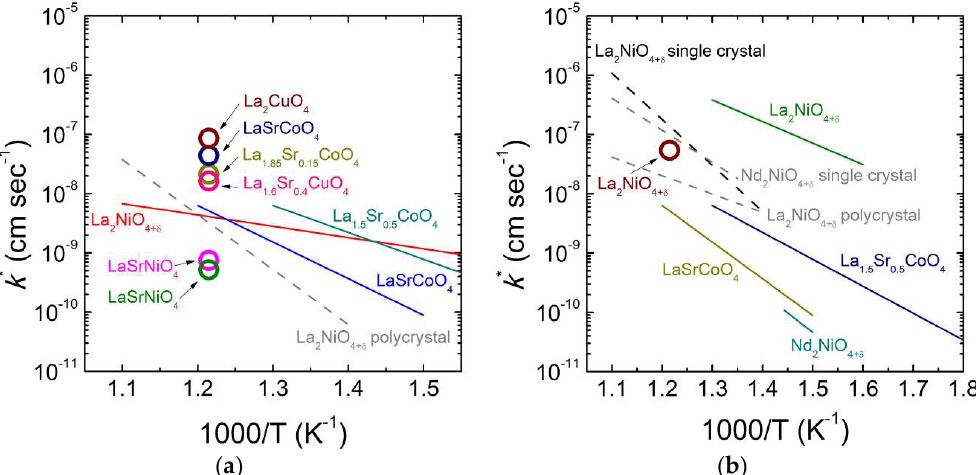
Figure 9. Arrhenius plots of surface exchange coefficients ( k * ) for different RP oxides: ( a ) k * along c-direction in La 2- x Sr x MO 4 (M= Cu, Co, Ni, [126,133,135,144]); and ( b ) k * along a-b plane in A 2- x Sr x MO 4 (A = Sr, La, Nd and M = Co, Ni, [61,65,128,133,135,144]) thin films.